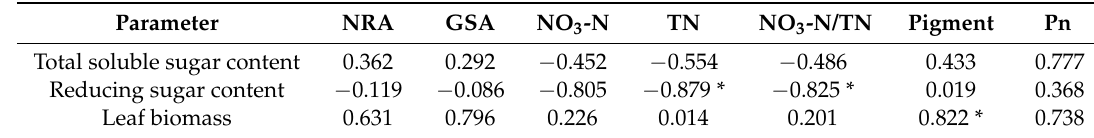
NRA: Nitrate reductase activity; GSA: Glutamine synthetase activity; TN: Total nitrogen content; Pn: Photosynthetic rate. Symbol * indicates significant differences at 0.05,